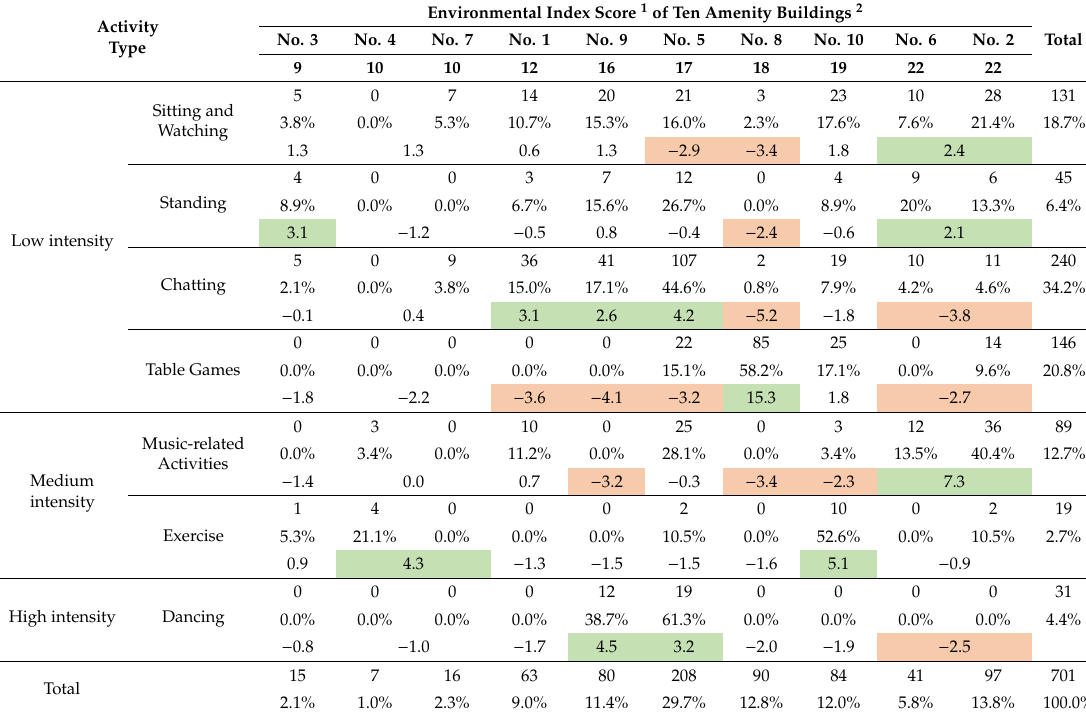
Table 6. Cross-tabulation of scored influencing factors (environmental index) by activity type.